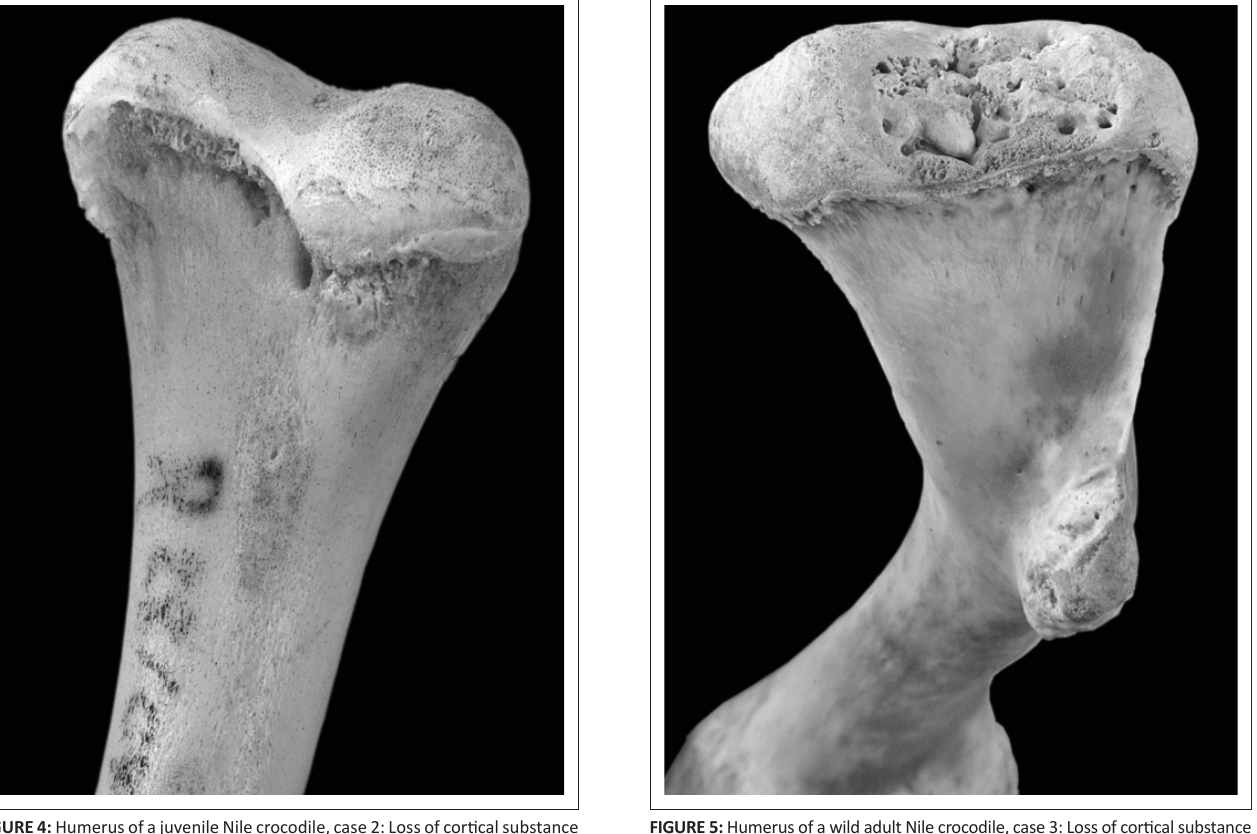
FIGURE 4: Humerus of a juvenile Nile crocodile, case 2: Loss of cortical substance on the lateral aspect of the distal epiphysis of the humerus.